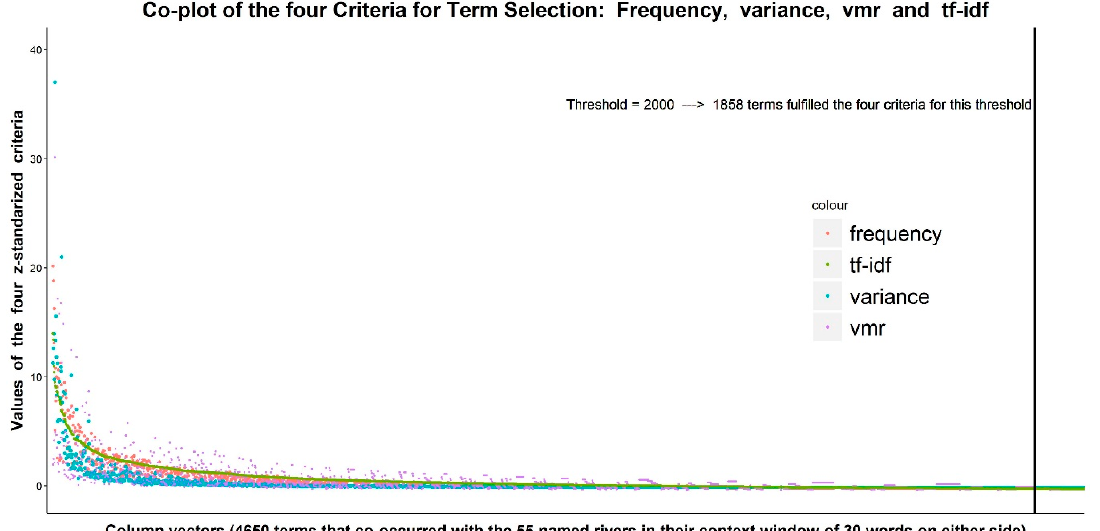
Figure 3. Co-plot of the four criteria for term selection.